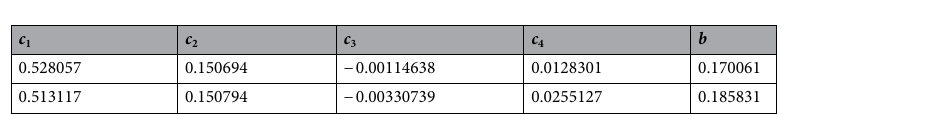
Table 2. The SGFD coefficients used to obtain the seismograms in Fig. 3. The first row is the implicit SGFD coefficients used for Eqs. (4) to (6), the second row is the HEI-SGFD coefficients used for Eq. (10).